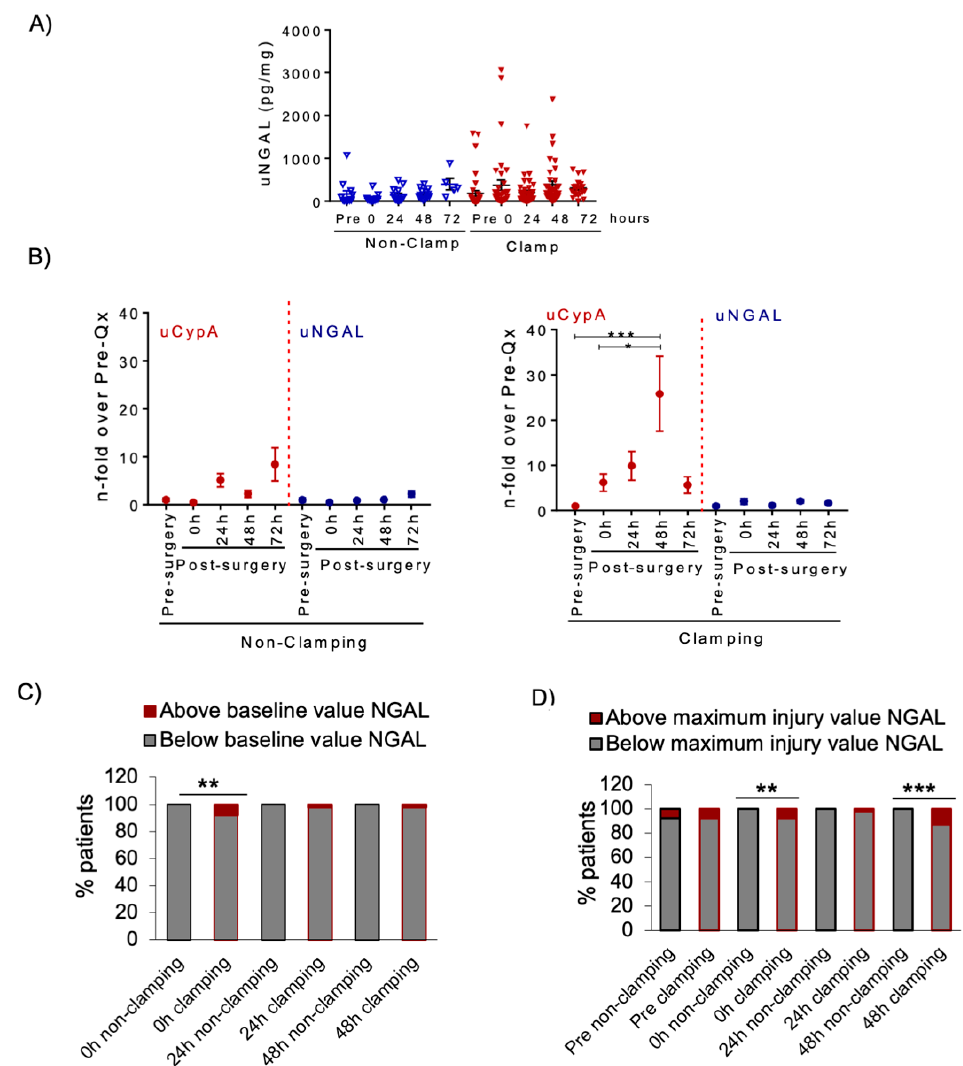
Figure 7. uNGAL levels in NSS patients. ( A ) uNGAL levels were measured in NSS patients before and after surgery and no statistically significant changes were observed. uNGAL is expressed as urinary NGAL: urinary creatinine ratio. Bars represent mean ± SEM. ( B ) Time-course of uNGAL and uCypA values expressed as fold-change over mean baseline pre-surgery values. Statistically significant increases over baseline were only observed for uCypA in clamping patients. Mean ± SEM, * p < 0.05; *** p < 0.001. ( C ) Percentage of patients with post-surgery uNGAL values above the highest pre-surgery uNGAL value found in the study population, i.e., >16 pg/mg. ( D ) Percentage of patients with post-surgery uNGAL values above the highest post-surgery uNGAL values obtained in NSS without clamping, ** p < 0.01, *** p < 0.001.